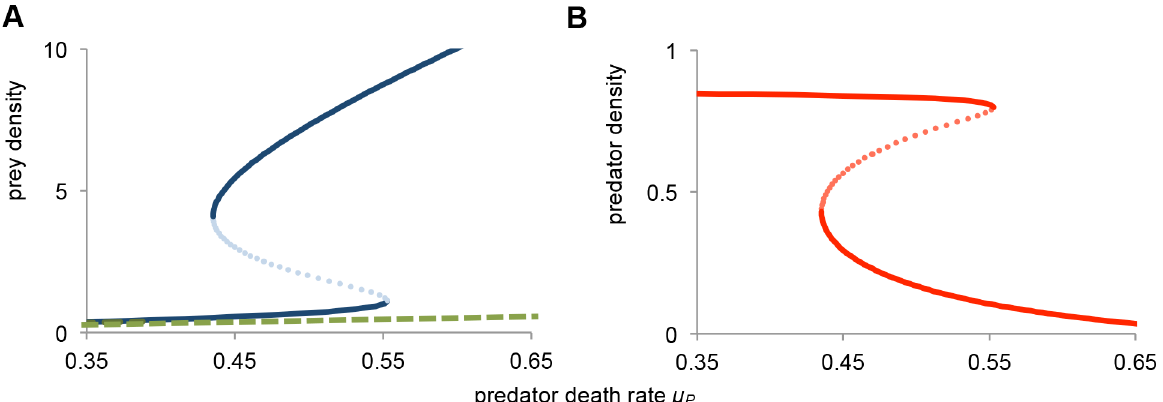
Fig 1. Bistability in the absence of disease. Bifurcation diagram as a function of predator death rate μ P . (a) Equilibrium prey density, juveniles J S in solid line (blue), and adults A in dashed line (green), and ( b ) Equilibrium predator density P (red). The equilibrium curves exhibit a so-called catastrophe fold, with a bistable region for 0.435 < μ P < 0.553. The unstable (saddle node) state is indicated with the dotted lines. Model parameters are b = 1, c = 1, d = 1, n = 1, φ = 1, μ J = 0.05, μ A = 0.1, and μ P variable.